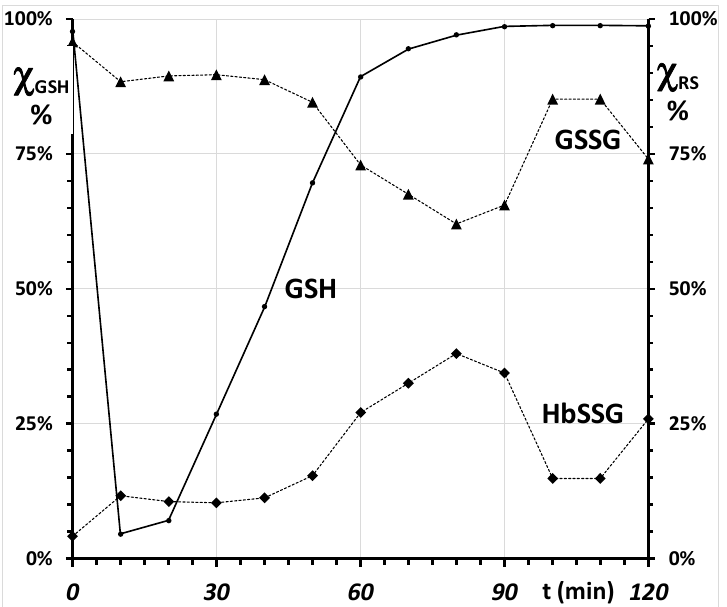
Figure 3. Partitioning of the glutathione pool during the RBC oxidative challenge experiment, as mole fraction ( χ %) of each thiol. Mole fraction of reduced glutathione GSH (left); (right) mole fraction of each disulfide form of oxidized glutathione: GSSG ( ) and HbSSG ( ).